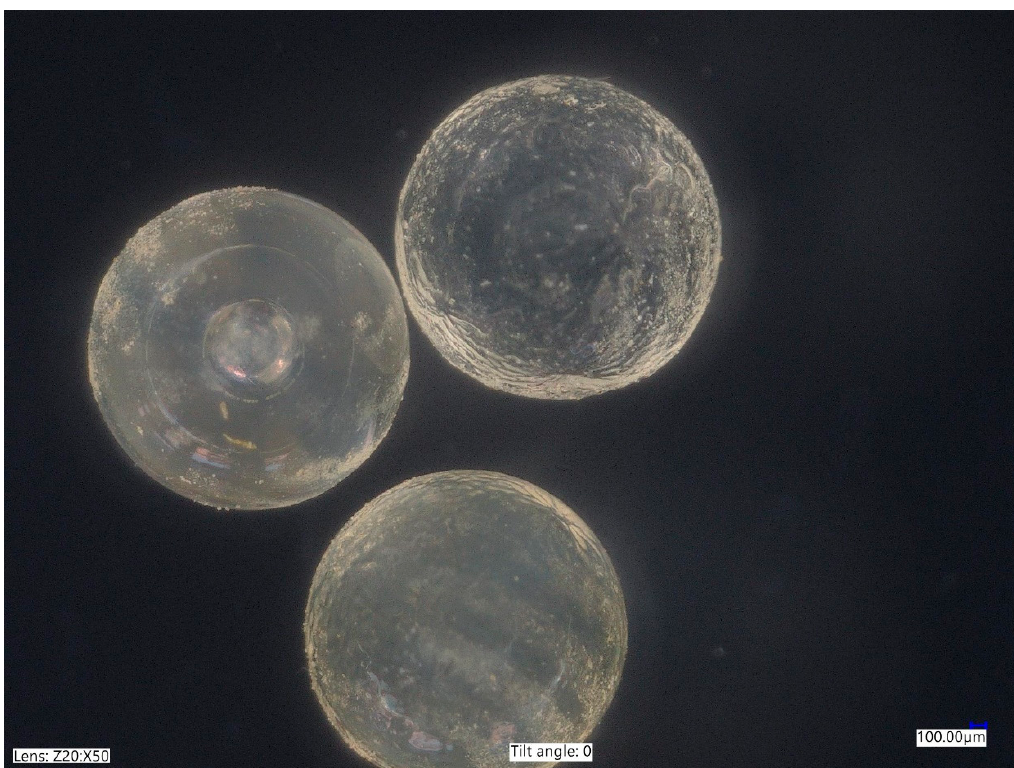
Figure 3. Microscopic photograph of non-saturated SAP B in dry conditions.